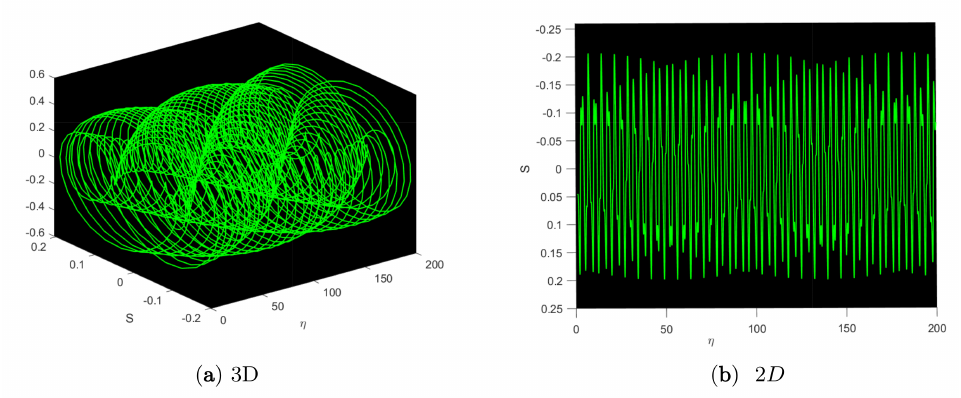
Figure 16. Phase portrait with perturbation term having a 1 = − 3, a 2 = − 3, a 3 = 3, n 0 = 0.91, and f = 4.3 for the dynamical system.